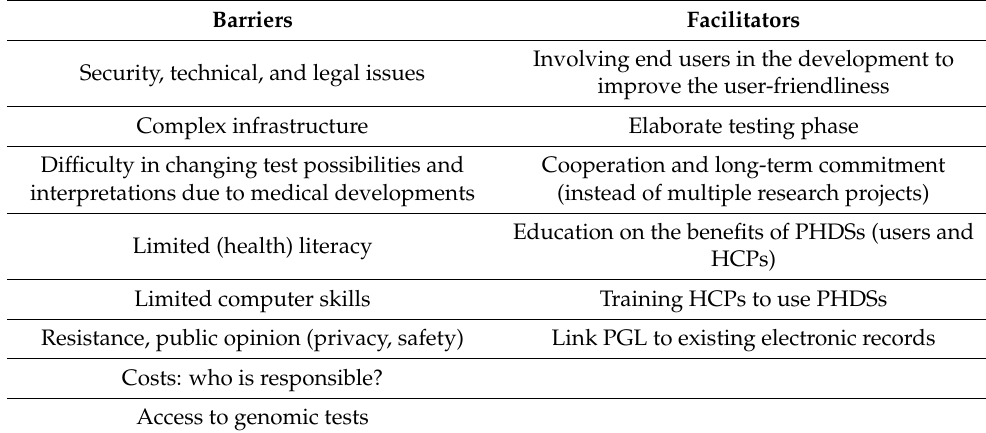
Table 11. Barriers to and facilitators of implementing a Personal Health Data Space in healthcare according to healthcare